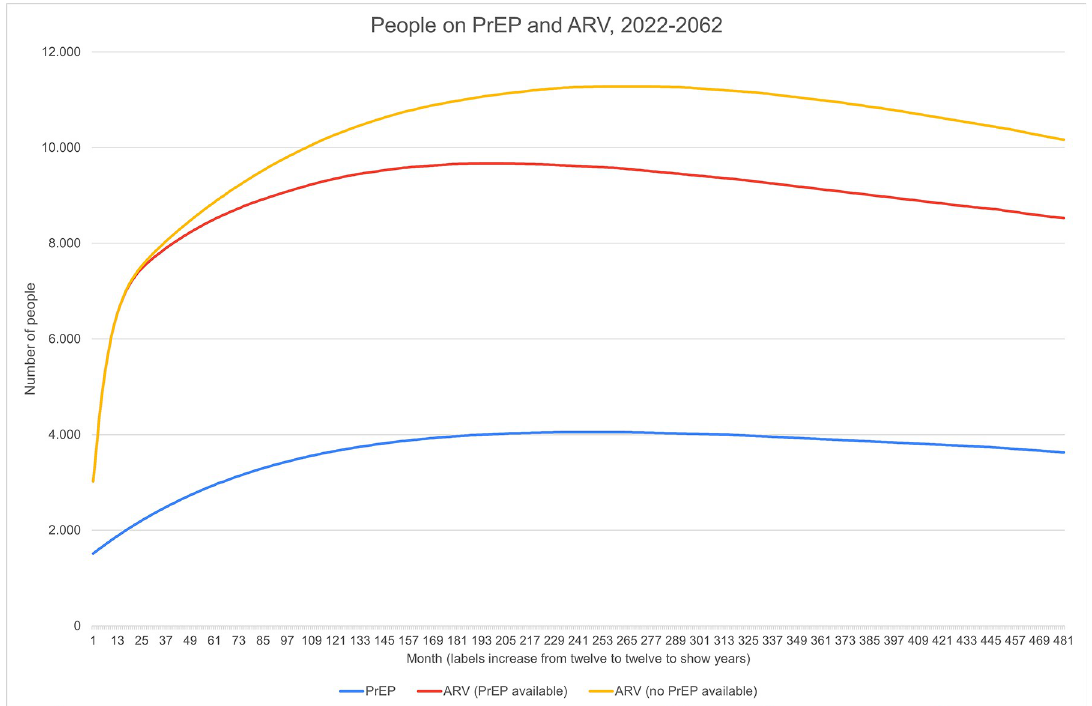
Fig 1. People on PREP and ARV, 2022–2062. Monthly evolution of the number of people on PrEP (blue), and ARV therapy in both scenarios (with PrEP, in red; without PrEP, in